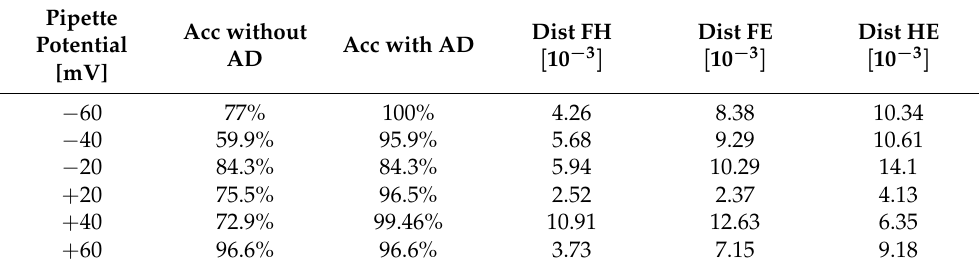
Table 1. Prediction accuracy of the cell lines performed on the test data set after cross-validation. First column indicates the pipette potential used in the experiment. Second and third columns show the accuracy without and with application of the anomaly detection technique, respectively. The remaining three columns present the average distances between the data corresponding to the different types of cells after its compression to the 2-dimensional latent space. The following abbreviations are introduced: Dist FH-the distance between the clusters representing fibroblasts and hippocampal cells; Dist FE-the distance between the clusters representing fibroblasts and endothelial cells, and Dist HE-the distance between the clusters representing hippocampal and endothelial cells.